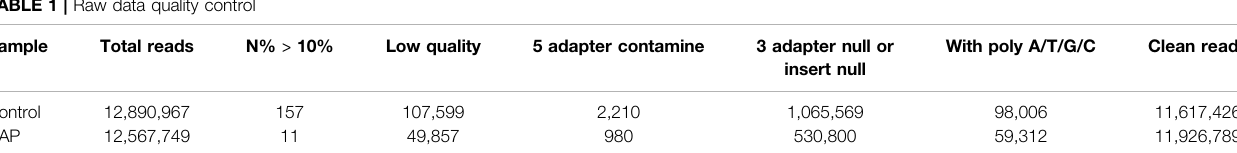
TABLE 1 | Raw data quality control